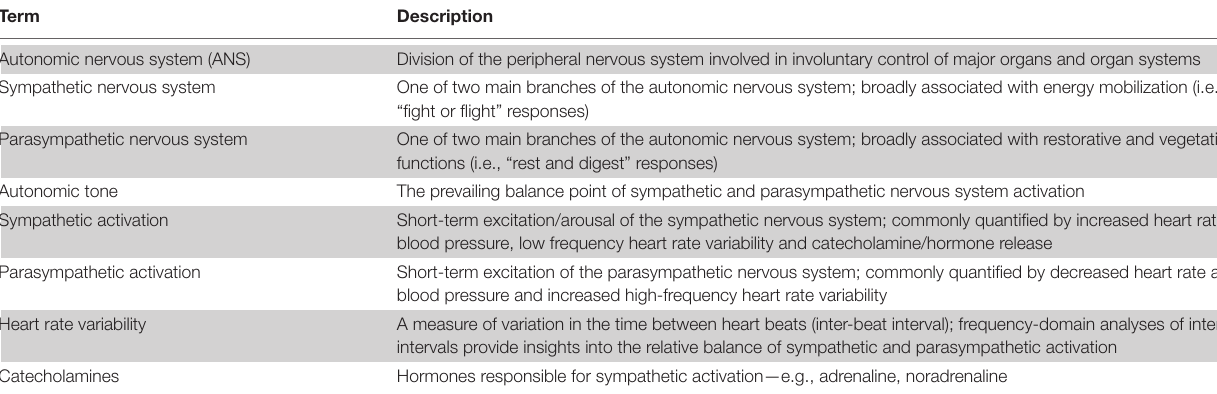
TABLE 1 | Glossary of key